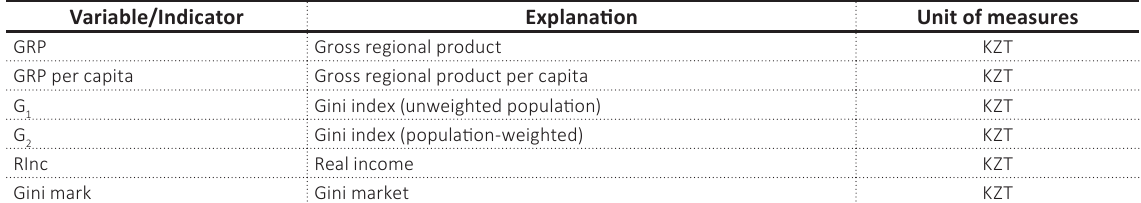
Table 1. Description of